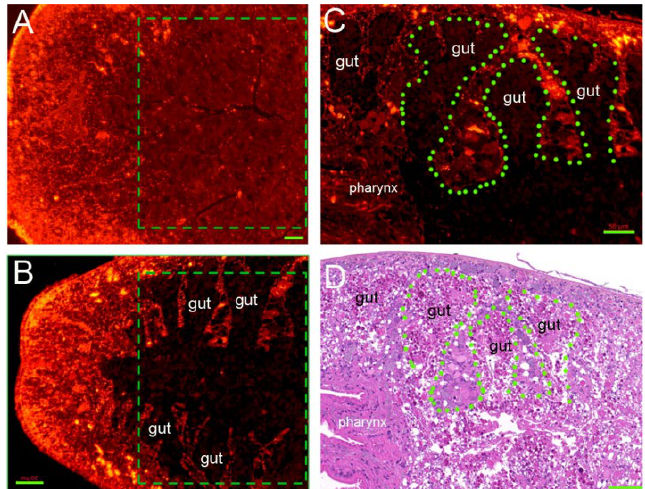
Figure 10. Distribution of HSP60 protein in control and RNAi-animals revealed by fluorescent immunostaining. Parts of differential region between control and RNAi were boxed. ( A ) Control section. ( B – D ) RNAi sections. C and D showed the same part of the body. The green dashed line indicates the border between parenchymal tissues and intestinal tissues. Animals with mild head- defects were collected for this experiment. Scale bar: 50 μm.